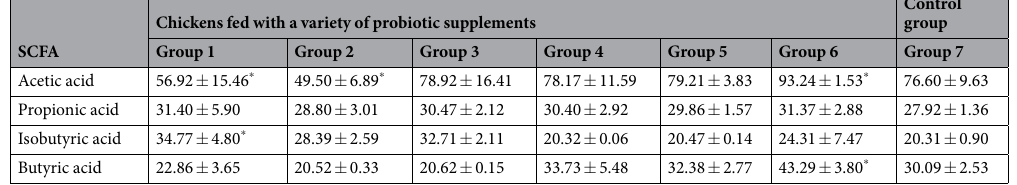
Table 3. Comparison of the concentrations of four short chain fatty acids (Mean ± Standard deviation) by caecal fermented between 6 different probiotic-treating groups and an untreated group by probiotic supplementation. Note: the * indicate significant differences (P < 0.05) between the probiotic-treating groups and control group.